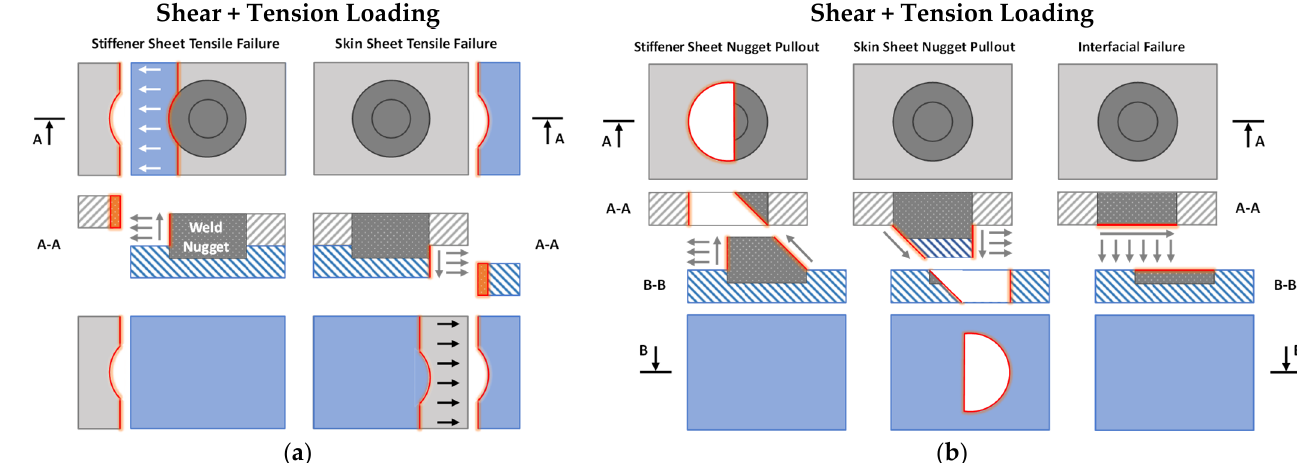
Figure 17. Schematics of refill spot weld failures caused by coupled shear-and-tension loading: ( a ) parent metal tensile failures and ( b ) nugget pullout failures and an interfacial failure. The graphics of each failure include the top view, the cross-section view, and the bottom view. The failure surfaces are highlighted in orange and red.